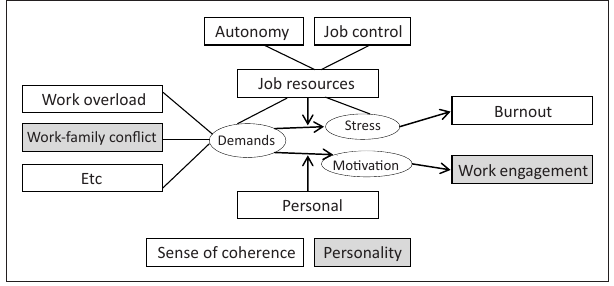
FIGURE 1: The job